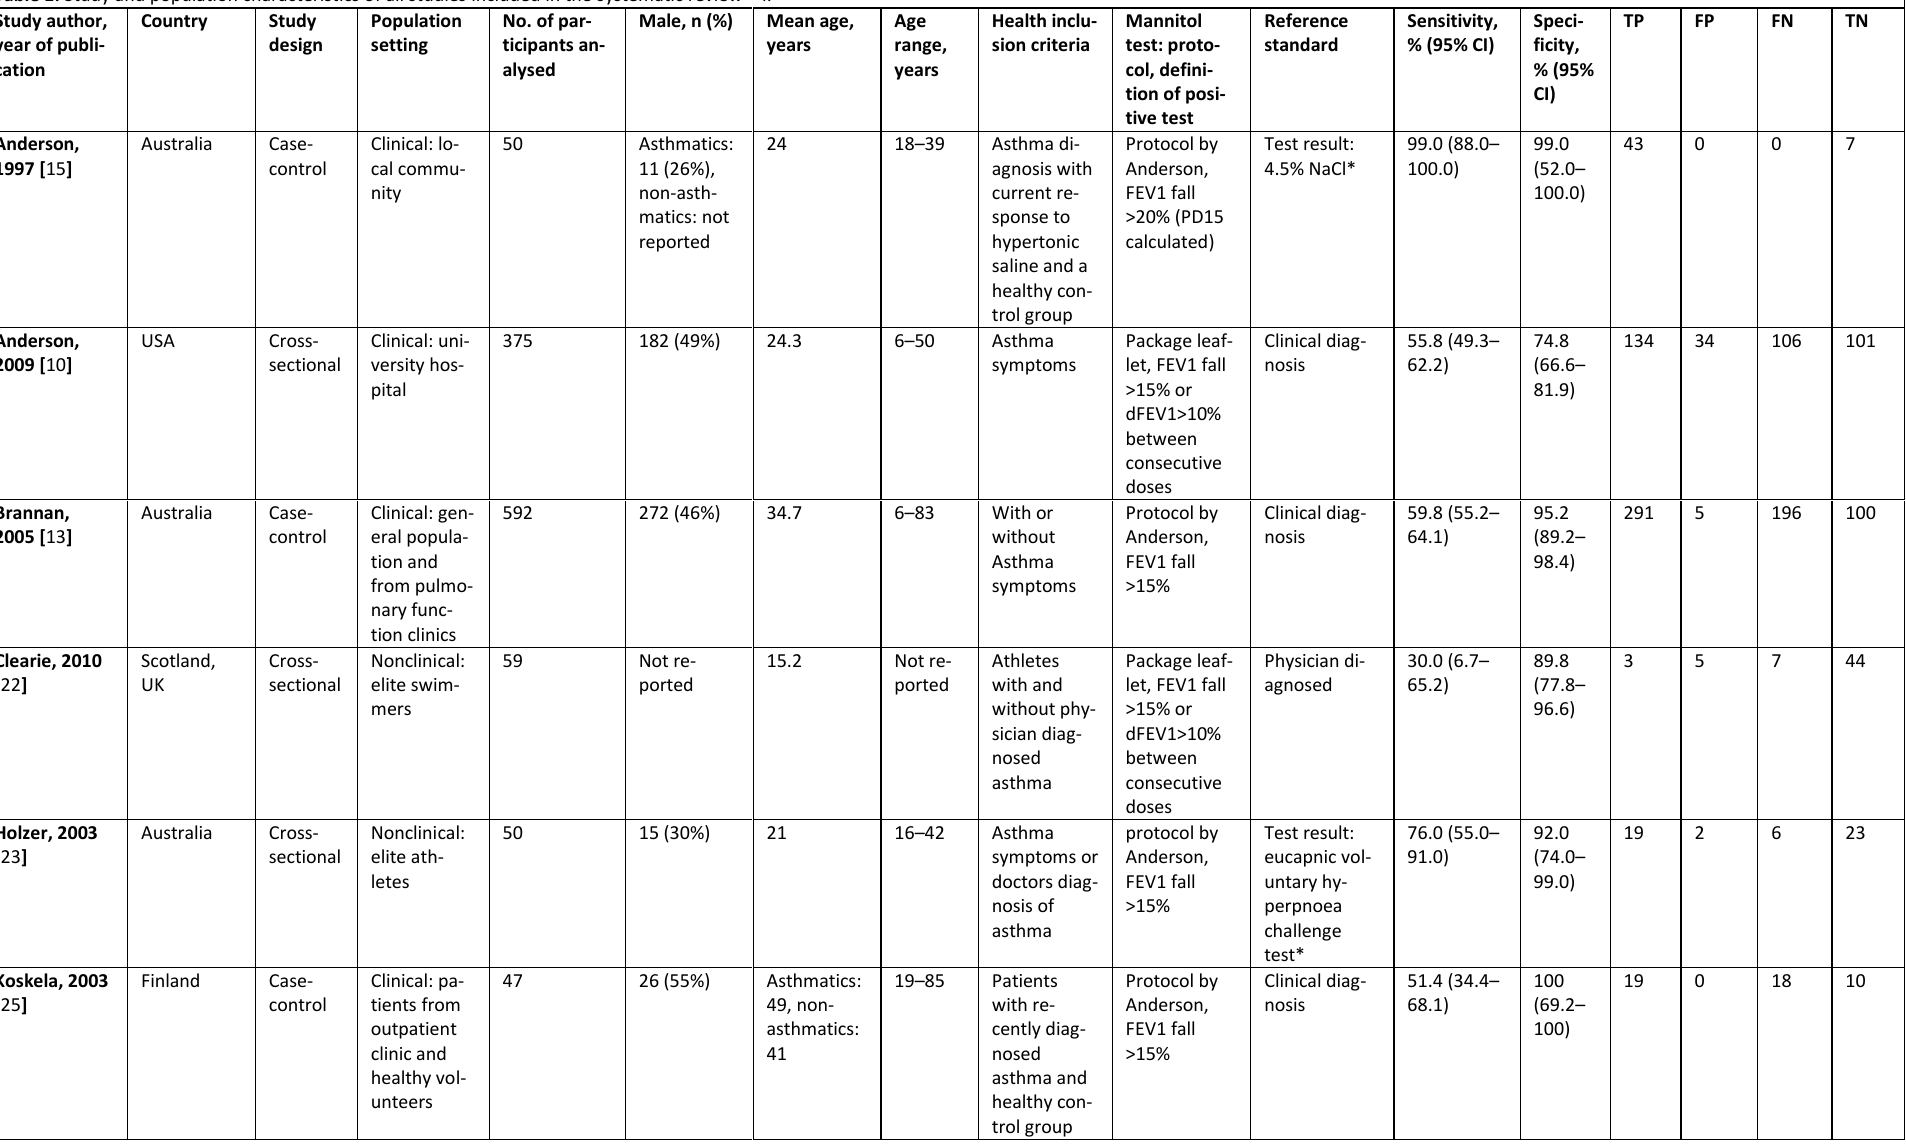
Table 1: Study and population characteristics of all studies included in the systematic review –